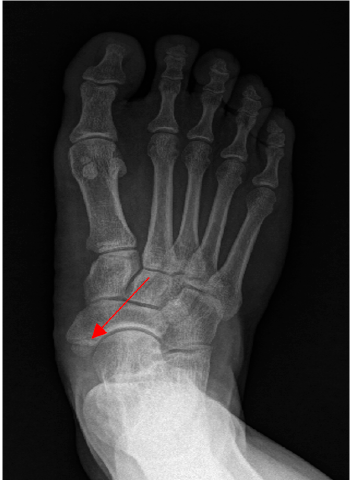
Figure 1. Patient’s accessory navicular bone (Arrow).